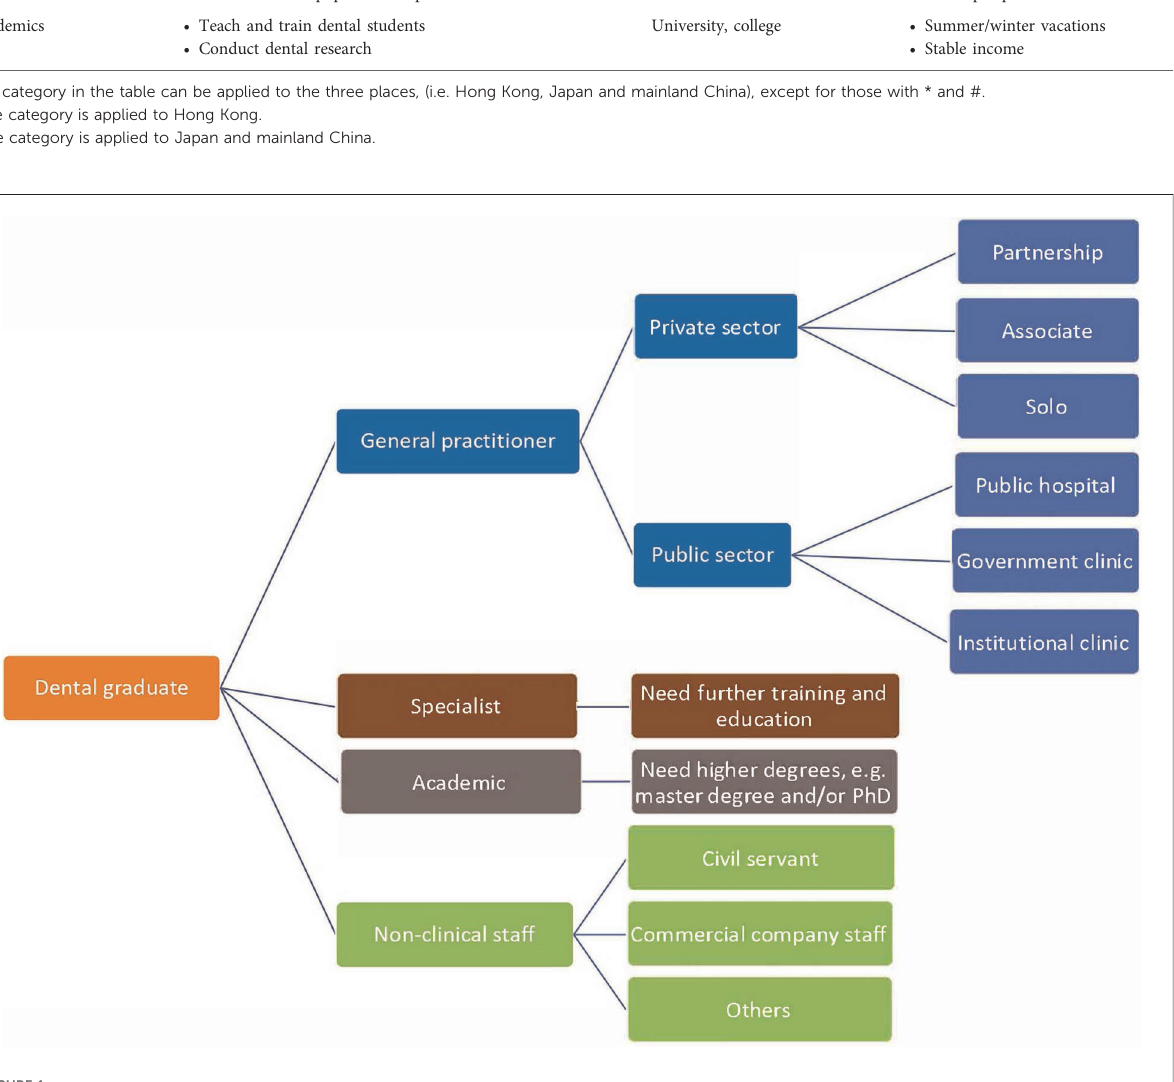
FIGURE 1 Career paths that dental graduates can